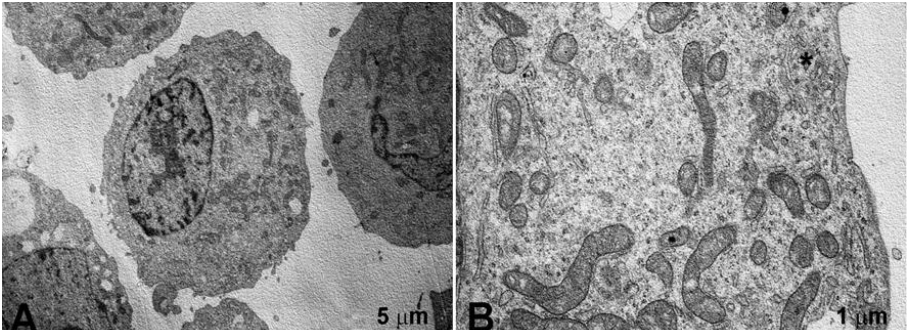
Figure 6. K562/DOXO cells after 15-min incubation with peroxidase-containing liposomes. ( A ) The cells show a normal ultrastructure and one of them (center) shows a cluster of membrane-bound, electron-dense particles, identified as liposomes, opposed to the plasma membrane. ( B ) Detail of the liposomes shown in ( A ), some of which are attached to the plasma membrane; mitochondria still show a normal appearance. ( C ) Cells showing moderate cytoplasmic vacuolation (see insert) and electron-dense particles corresponding to liposomes (arrowheads). ( D ) Detail of the cell in ( C ).